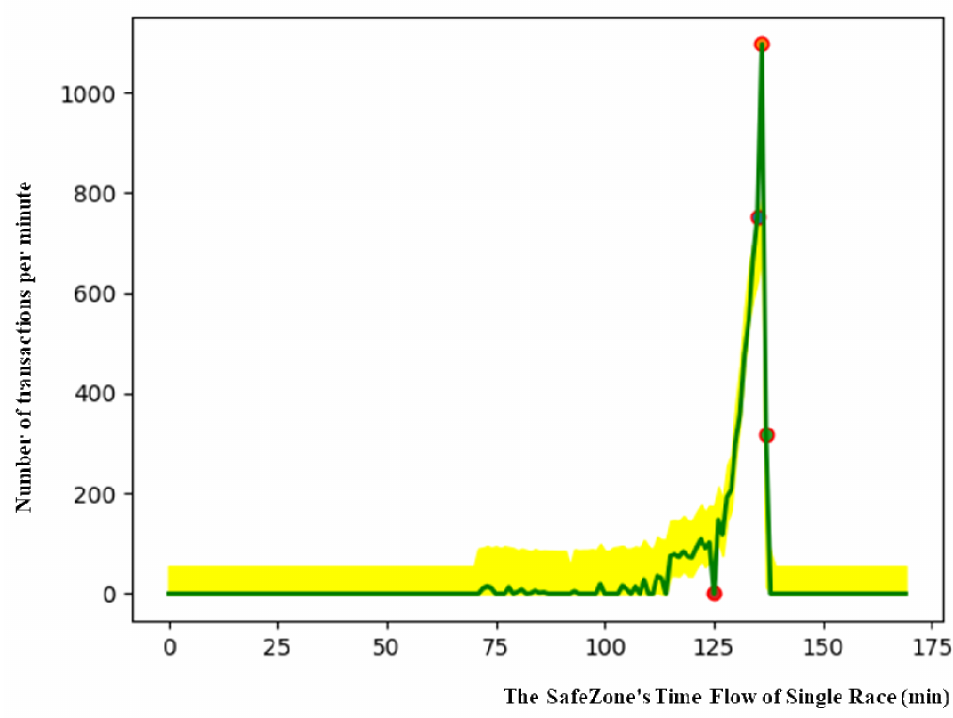
Figure 5. Example of SafeZone and anomaly detection. The red circle is a detected anomaly. Monitoring the detection of anomaly points could be a useful solution in real life for protecting games and improving online security in general against anomalies. other branches, indicating systemic fraud. Figure 6 shows outliers in the Walkerhill data.